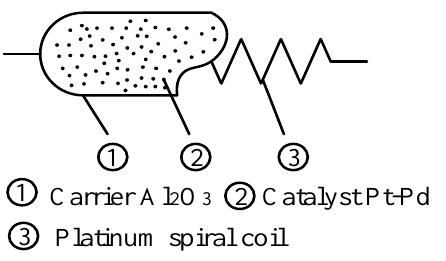
Figure 2. Structure of a catalytic